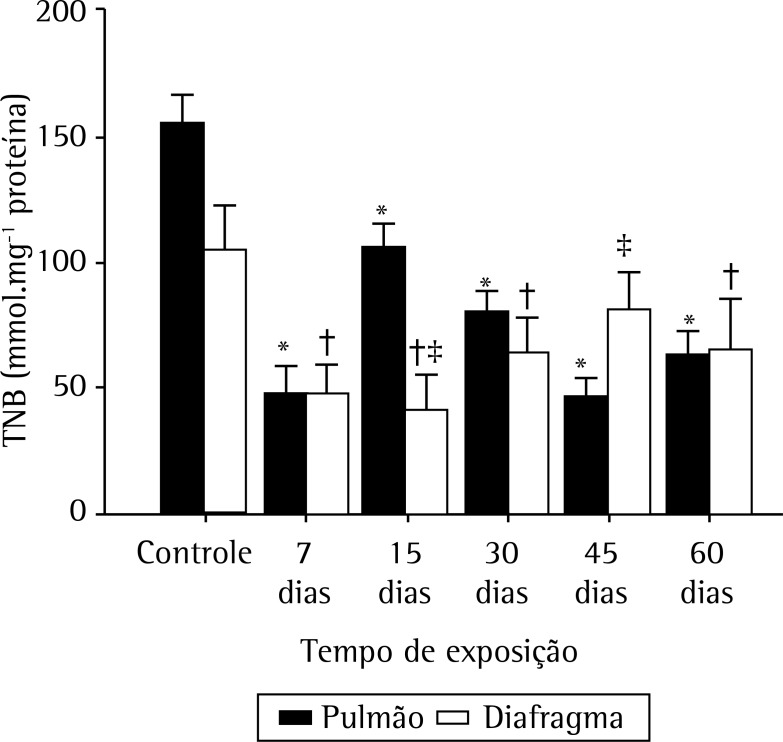
Média ± EPM dos níveis de ácido 5-tio-2- nitrobenzoico (TNB) no tecido
pulmonar e no músculo diafragma em 6 grupos de camundongos: grupo controle e
5 grupos expostos a fumaça de cigarro por 7, 15, 30, 45 e 60 dias,
respectivamente. * p < 0,05 vs. controle no tecido pulmonar. † p <
0,05 vs. controle no músculo diafragma. ‡ p < 0,05 vs. tecido
pulmonar.